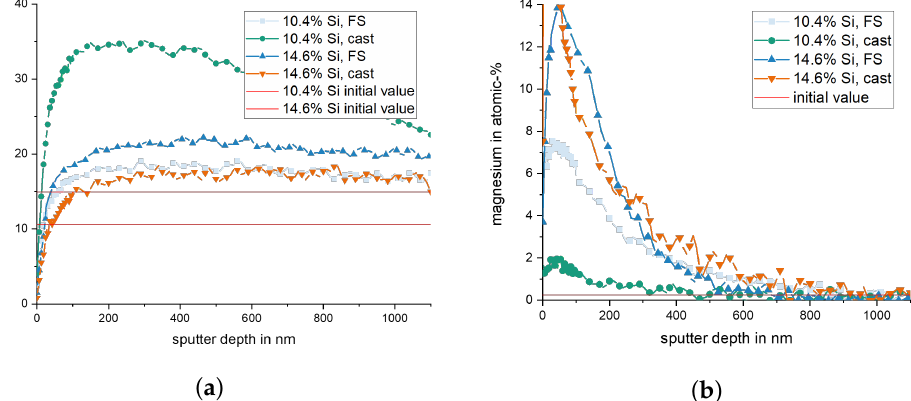
Figure 11. ( a ) Silicon content over sputtering depth (XPS) and the initial values for the different materials. ( b ) Magnesium content over sputtering depth.